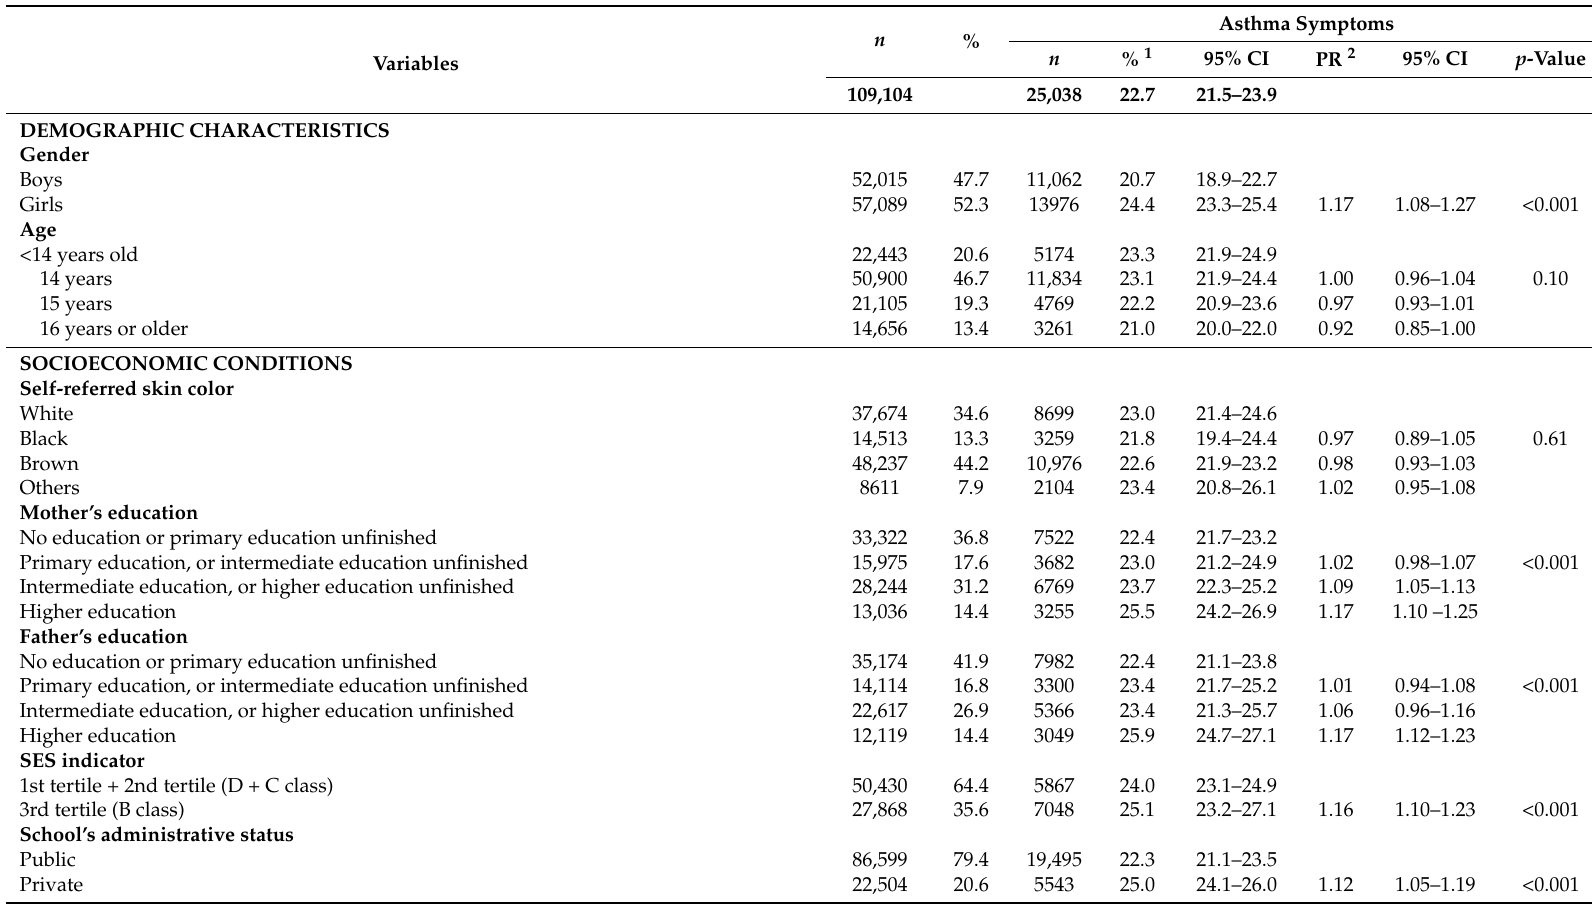
Table 1. Pense 2012—Asthma Symptoms in Brazilian Middle School students: Characteristics Studied and Asthma